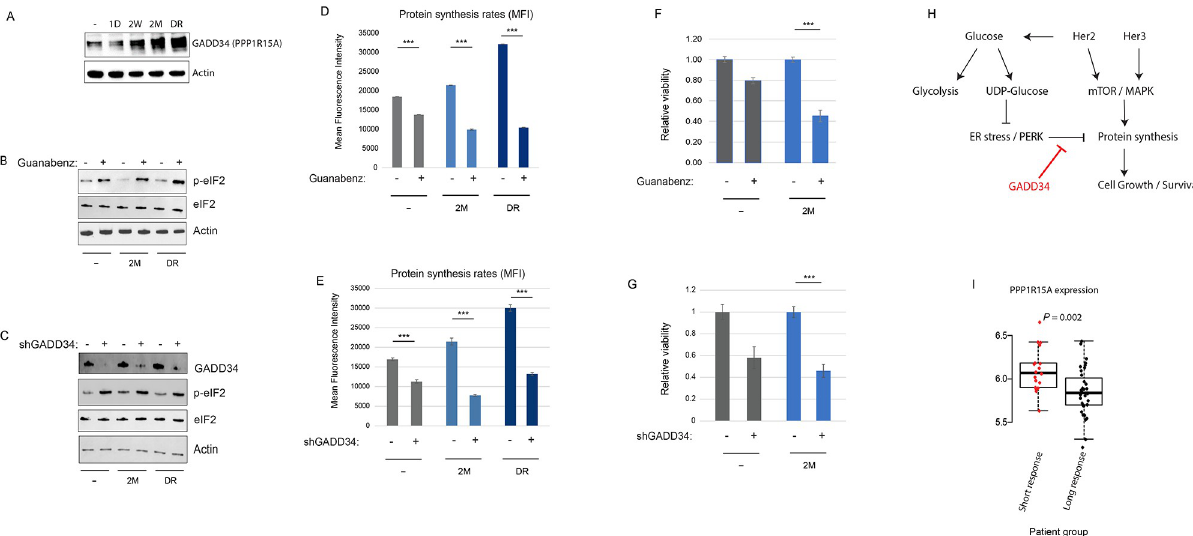
Fig 5. GADD34 overexpression during prolonged lapatinib treatment allows to overcome ER stress response-mediated inhibition of protein synthesis. A) Protein levels of GADD34 (PPP1R15A) in the indicated conditions. B-C) Western blot of p-eIF2 (S51) under indicated conditions with and without treatment with guanabenz (GADD34 inhibitor) (B) or GADD34-targeting shRNA (C). D-E) Relative viability of cells at the control (parental) and relapse (2M) stages in response to 72hr treatment with guanabenz (D) or shRNA against GADD34 (E). F-G) Protein synthesis rate measurement with Click-iT Protein synthesis kit in the indicated stages of lapatinib treatment with and without guanabenz (F) or shRNA targeting GADD34 (G). Data is presented as mean fluorescence intensity (MFI). H) A model summarizing the signaling, metabolic and proteostatic changes during the acquisition of resistance to lapatinib in SKBR3 cells. I) mRNA levels of PPP1R15A in the cohort of advanced Her2+ breast cancer patients (n = 53 samples) with short ( < 1 year) or long ( > 3 years) duration of response to first-line trastuzumab therapy, from the Long-HER study (33). Statistics: Error bars show standard deviations of 2 (D-E) or 3 (F-G) replicate samples. Data are representative of at least 2 independent experiments (D, F). ��� : P < 0.01 with student’s t-test. Densitometric quantitation of the immunoblotting data are provided in S1 Table.